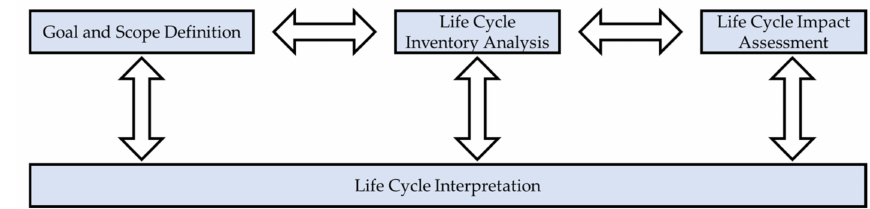
Figure 1. A schematic view of LCA